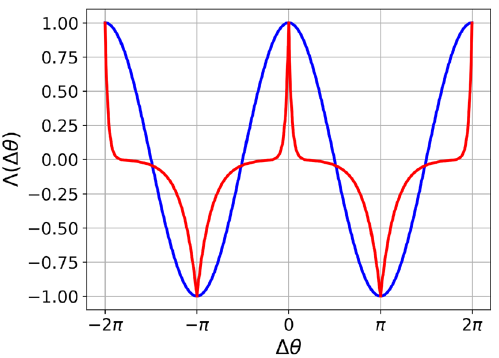
Figure 1. Hebbian phase difference-dependent plasticity functions �(�θ) versus �θ . In blue the function (cid:31) 0 reported in Eq. (3) and in red the function (cid:31) 1 defined Eq. (4). Despite having different potentiation and depression phase windows, the two functions attain the same maximum and minimum